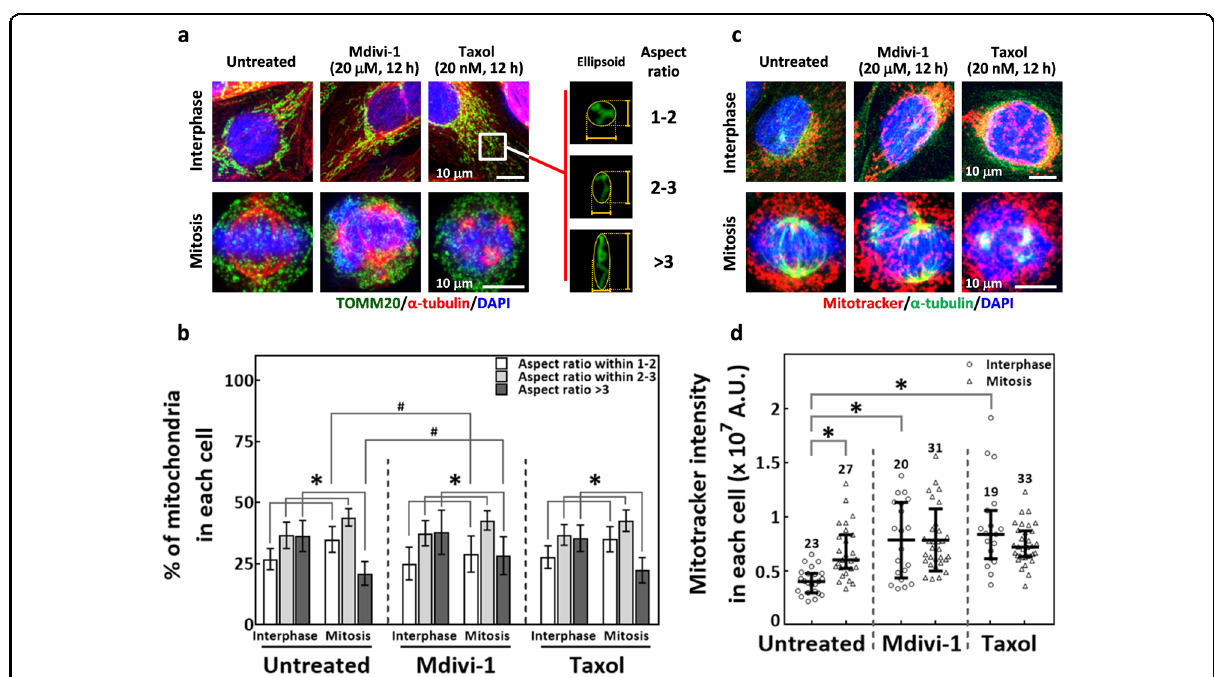
Fig. 4 Mitochondrial morphology and functions are not signi fi cantly altered in cells with mdivi-1-induced mitotic defects. a (Left) Representative images show mitochondrial morphology in interphase (upper) and mitotic (lower) cells that were treated as indicated. Mitochondria were revealed by TOMM20 immunostaining (green), and the cells were counterstained for α -tubulin (red) and chromosomes (blue). (Right) The illustration depicts the level of mitochondrial fragmentation, as represented by the aspect ratio of circumscribed ellipsoids that were obtained as described. The ovals illustrate the circumscribed ellipsoids and the yellow lines delineate the longest and the shortest axis of the ellipsoid. The representative images show mitochondria with aspect ratios of 1-2, 2-3, and >3. b Mdivi-1 did not prominently alter the characteristic changes in mitochondria morphology during the G2-M transition. The percentages of mitochondria within each cell that exhibit the indicated aspect ratio are shown as mean ± SD from at least 20 cells collected from two independent experiments. * p < 0.05 comparing mitosis to interphase by Student ’ s t test. # p < 0.05 comparing drug-treated groups to untreated by Student ’ s t test. c Representative images of interphase (upper) and mitotic (lower) cells that were treated as indicated. Cells were stained with MitoTracker Deep Red (mitotracker, red) and counterstained for α -tubulin (green) and chromosomes (blue). d Mdivi-1 did not prominently affect the mitotracker intensity in arrested abnormal mitotic cells. The relative total mitotracker intensity in each cell was measured as described. The scatter plot shows the interquartile distribution of the mitotracker intensity in cells collected from two independent experiments; numbers indicate the cells measured. * p < 0.05 by Mann – Whitney Rank Sum